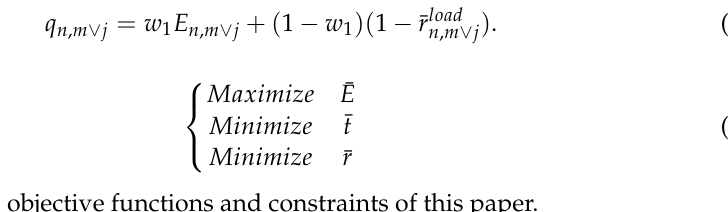
Table 3 lists the objective functions and constraints of this paper. Table 3. Object function for